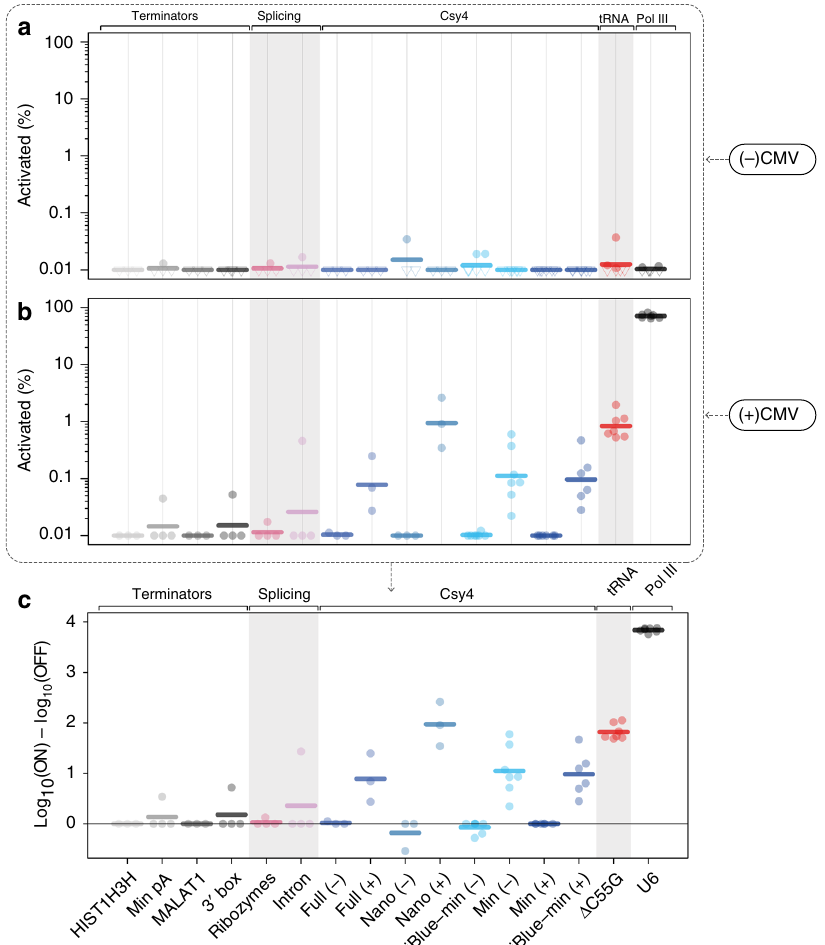
Fig. 5 Comparison of top performing tRNA Pro Δ C55G engineered variant with other reported systems for speci fi c Pol-II sgRNA expression. a , b Percent reporter ECFP + cells within transfected cells for the OFF state (no CMV promoter) ( a ) and the ON-state (with CMV promoter) ( b ). Points at or below the limit of detection are shown as hollow downward triangles. c Log 10 (% ECFP + cells) in the ON condition (with CMV promoter) compared to OFF condition (no CMV promoter). Thick lines represent geometric mean values ( n = 3 – 6 independent experiments). Terminators refer to the use of alternative termination sequences to the standard poly A and include the histone 1h3h terminator, a minimal poly A sequence 5 , the MALAT 1 terminator 5 , as well as the U1 snoRNA 3 ′ box 5 . The ribozyme scaffold contains a gRNA fl anked by hammerhead and HDV ribozymes 7 . The intron system contains a gRNA embedded within an arti fi cial intron inside the mKate fl uorphore 6 . Csy4 variants include the full Csy4 target sequence 4 , the Csy4 Nano target from 19 , and minimal Csy4 targets 27 either on its own in a transcript, or in the 3 ′ UTR of an iBlue transcript. ( + ) indicates that the Csy4 protein is present, and ( − ) indicates that it is absent. Source data are provided as a Source Data fi